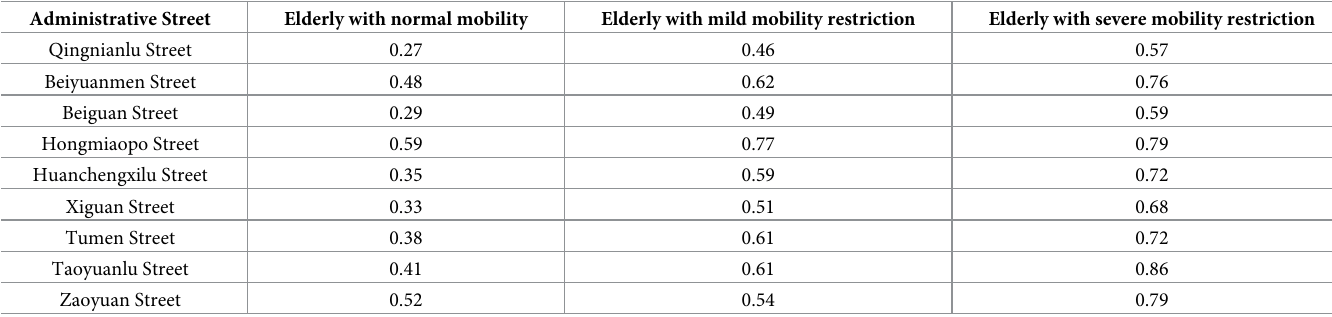
Table 4. Gini coefficient of community home care